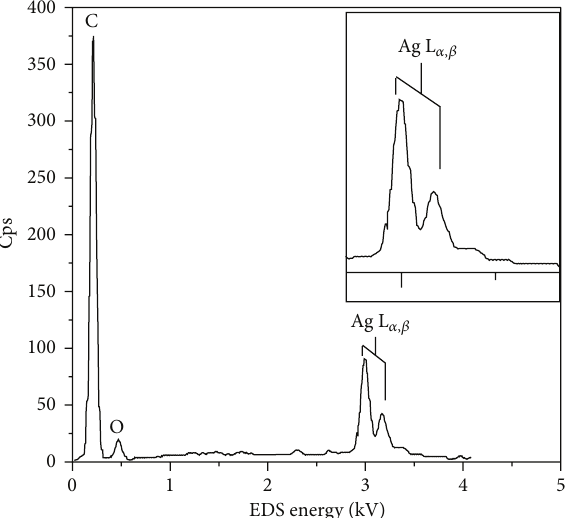
Figure 3: Nylon-6,6 without and with Ag nanoparticles formed at different AgNO 3 concentrations.